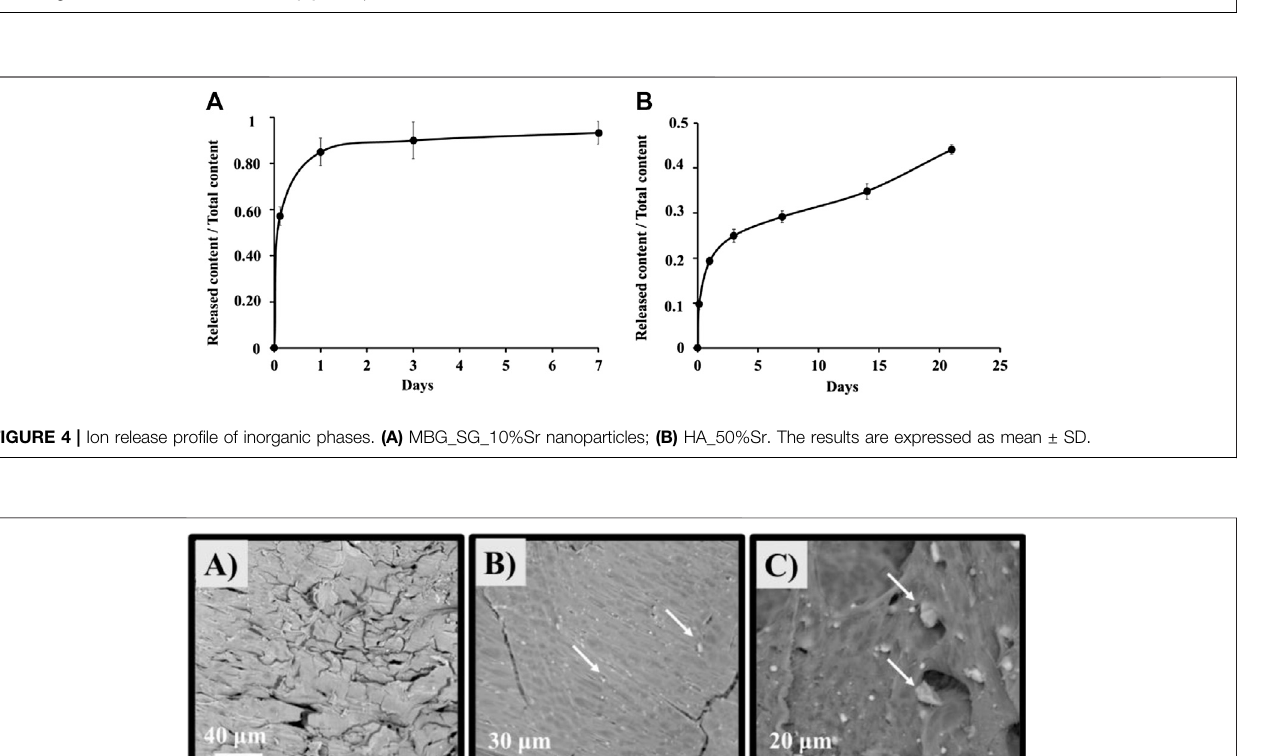
FIGURE 3 | (A) FE-SEM micrographs of HA_50%Sr nanoparticles.; (B) EDS of HA_50%Sr marking peaks for Ca and Sr (arrows) with table indicating the atomic percentage estimated for each element; (C) XRD pattern of HA_50%Sr.